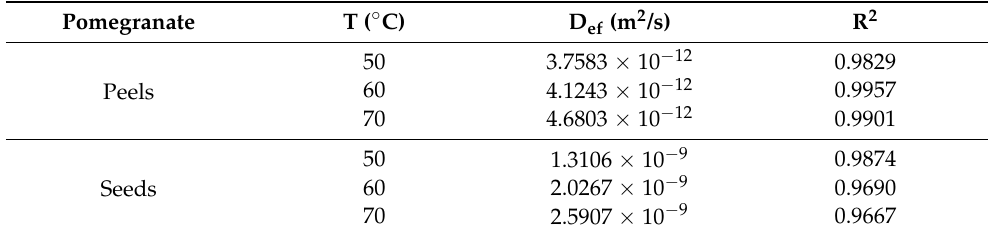
Table 5. Effective diffusivities (D ef .) were obtained in the drying kinetics of pomegranate peels and seeds at temperatures of 50, 60, and 70 ◦